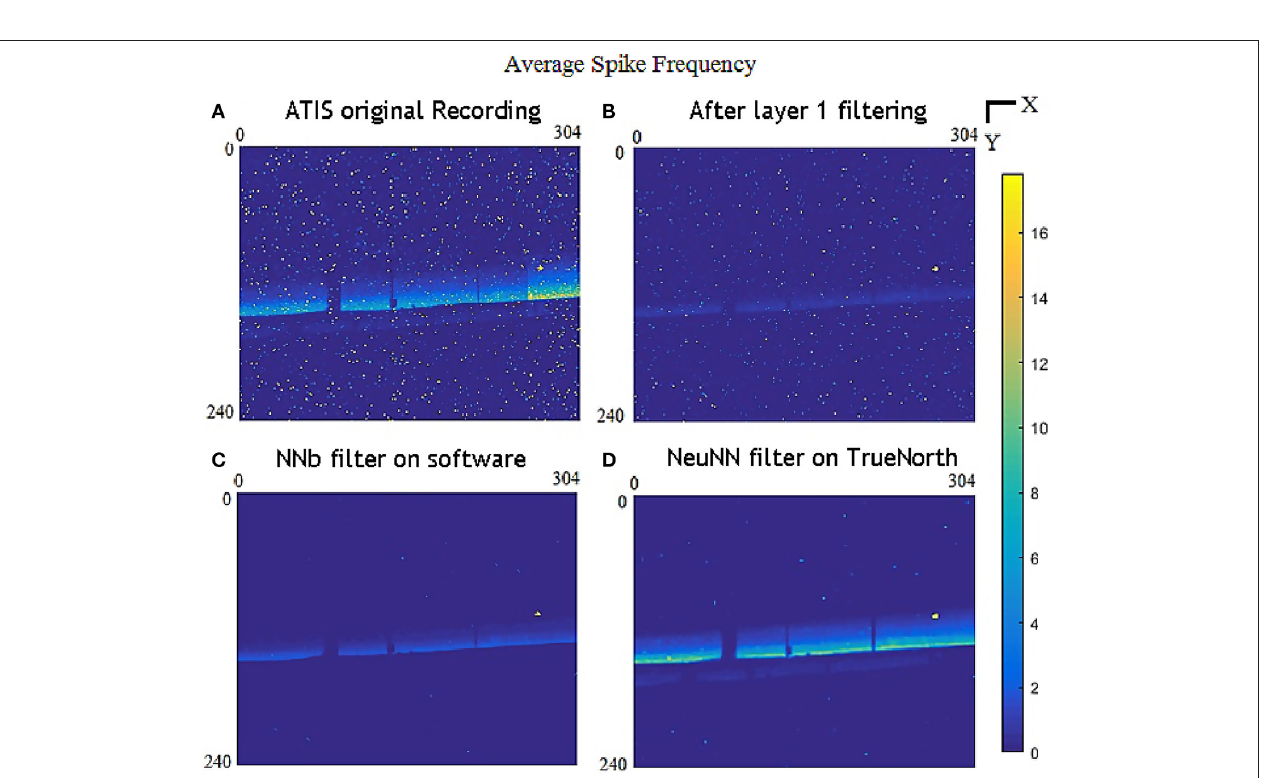
240 pixels combining all the sample files for (A) original data; (B) ×